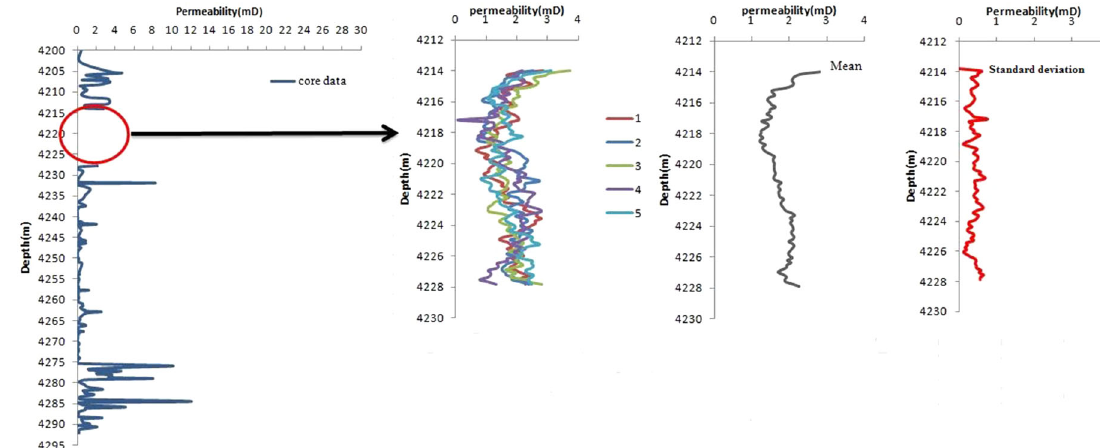
Fig. 13 Realizations-based fBm for permeability distribution of Fahliyan reservoir